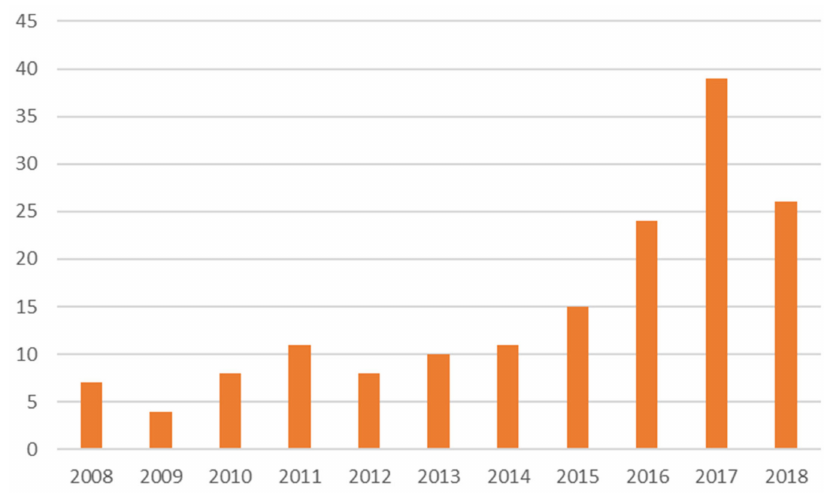
Figure 2. Distribution of resources over the decade.